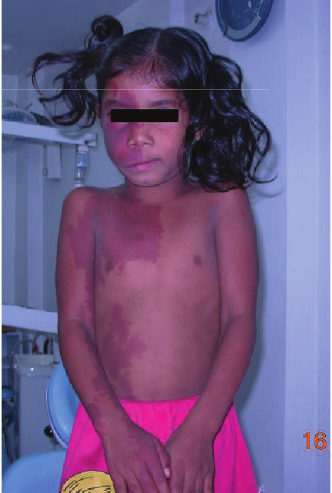
Figure1:Extraoralunilateralinvolvementofportwinestainonface, neck, chest, abdomen, and hand.